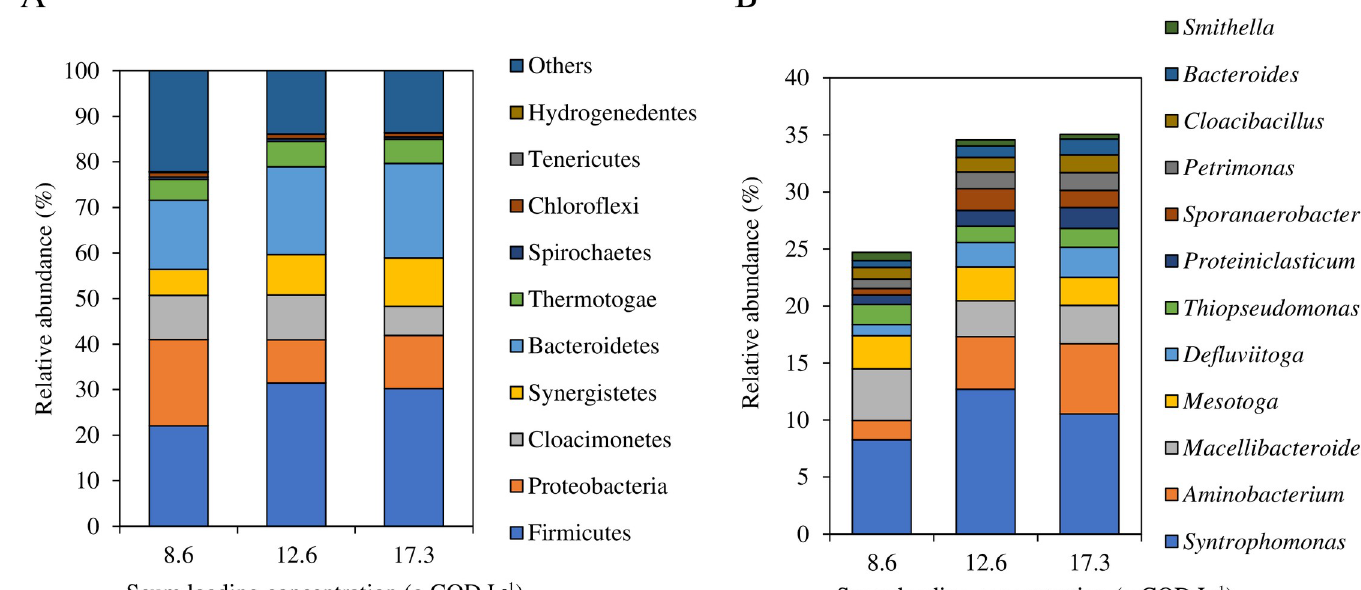
PLOS ONE | https://doi.org/10.1371/journal.pone.0257651 September 30,